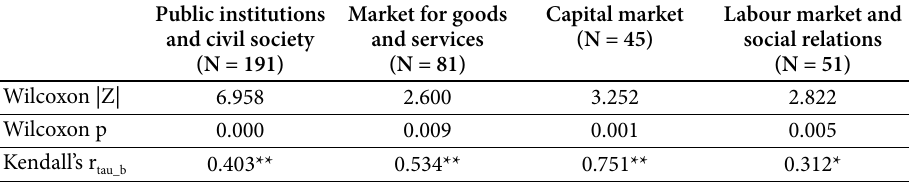
Table 2. Correlation analyses and Wilcoxon tests: comparison of Swiss and Lithuanian